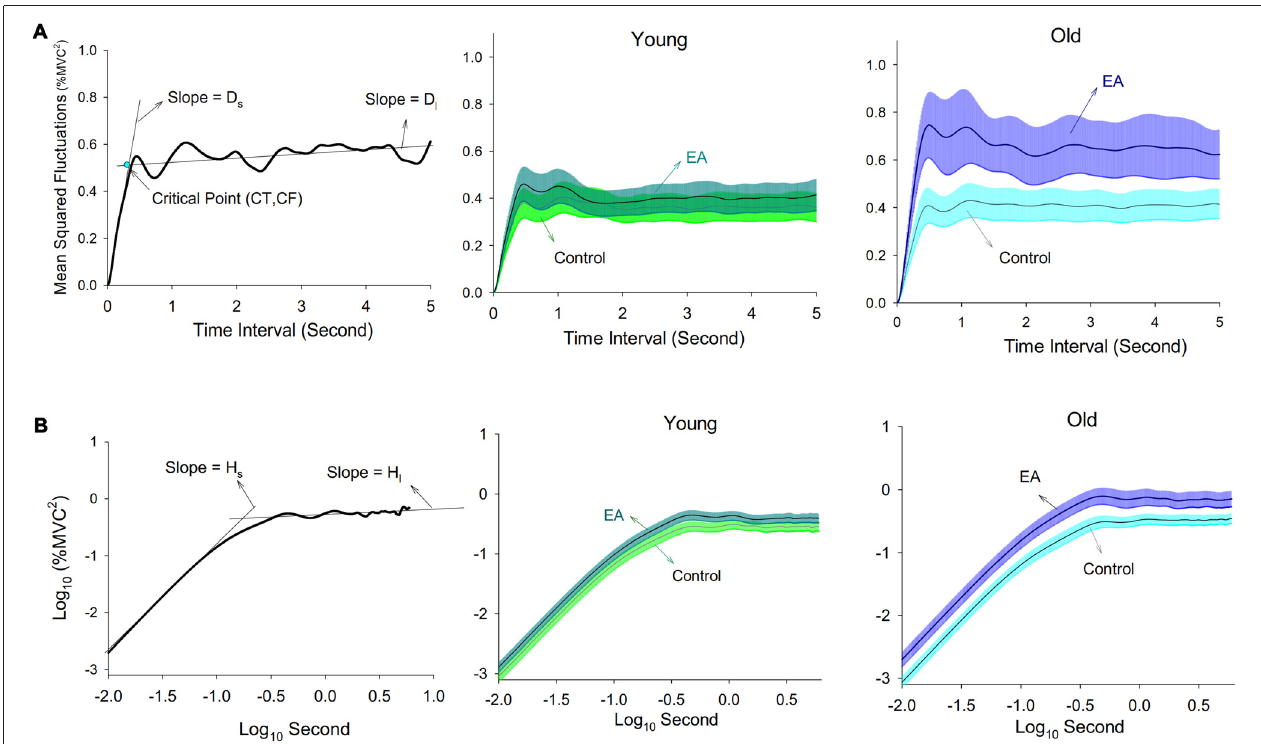
FIGURE 2 | Diffusion plot. (A) The left plot is a typical linear-linear diffusion plot. The computed critical point ( ∆ t c , <(cid:49) F 2 c > ), short-term effective diffusion coefficient (D s ), and long-term effective diffusion coefficient (D l ) are labeled. The critical point indexes the turning point of variation in open-loop and closed-loop control of the stochastic dynamics for force fluctuations. The middle and right plots are pooled linear-linear diffusion plots of the young and old adults. (B) The left plot is a typical log-log diffusion plot. The computed short-term scaling exponent (H s ) and long-term scaling exponent (H l ) are labeled. The middle and right plots are pooled log-log diffusion plots of the young and old